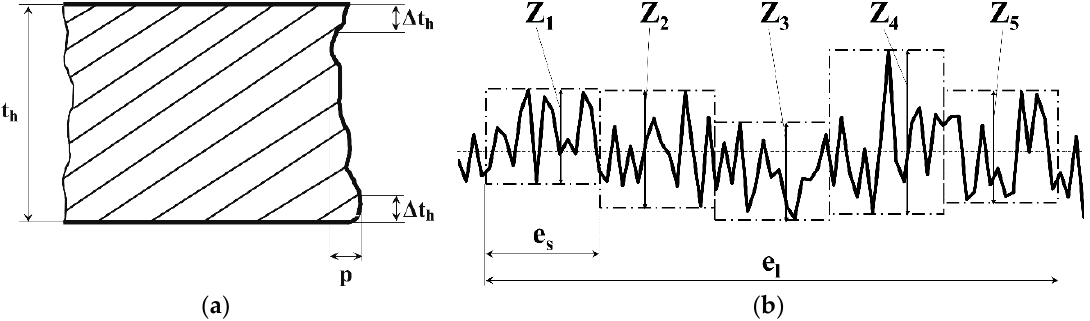
Figure 2. ( a ) Example of a through-thickness cross section of a cut sheet used to measure perpendicularity tolerance; ( b ) mean height of the surface profile, as evaluated on a cut surface: Z1, …, Z5, single profile element; e l , evaluation length; e s , single sampling length.